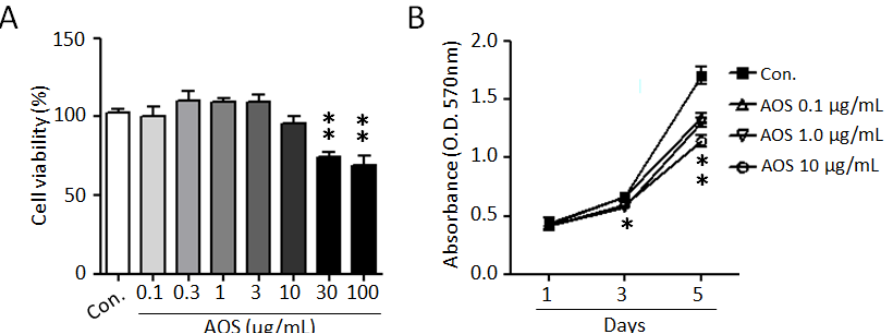
Figure 1. AOS inhibits the proliferation of BPH-1 cells. ( A ) BPH-1 cells were treated with different concentrations of AOS for 24 h and cytotoxicity was measured via an MTT assay. ( B ) BPH-1 cells were cultured in the absence (Con.) or the presence of AOS (0.1, 1.0, 10 μg/mL) and cell proliferation was measured after 1, 3, and 5 days. All data are shown as mean ± standard deviation of at least four independent experiments. * p < 0.05, and ** p < 0.01, compared with the control group (Con.).